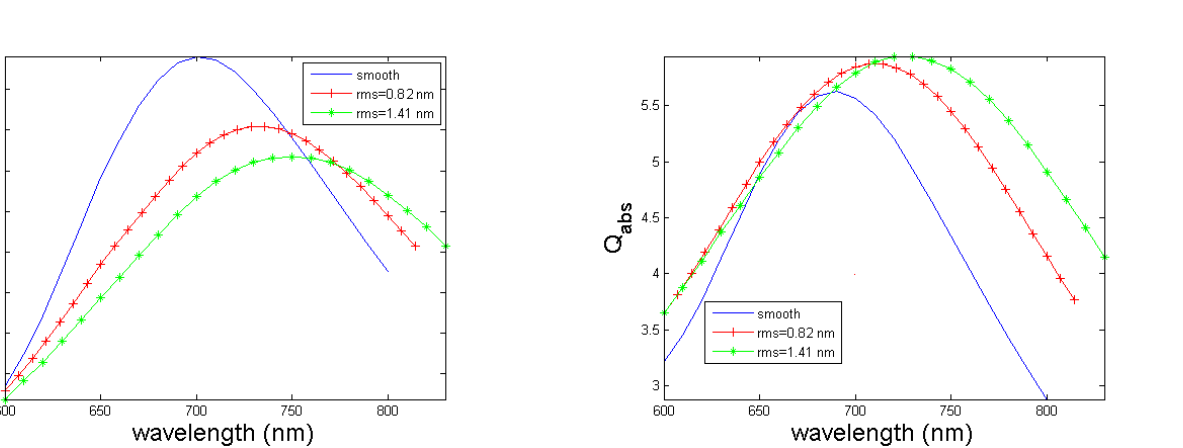
Figure 7: Absorption efficiency spectra of nanoantenna- based biosensor for smooth (blue curves) and rough topog- raphy.